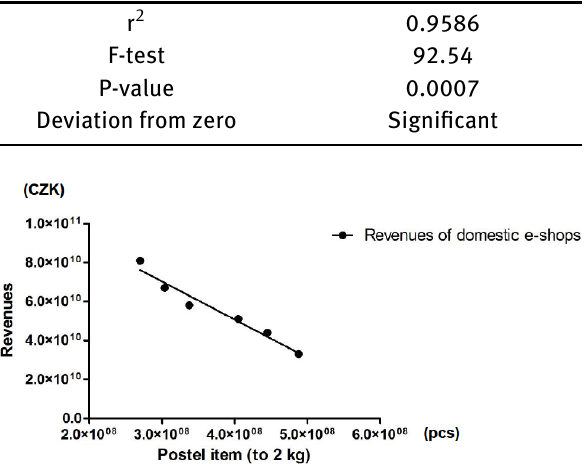
Table 3: Analysis results.